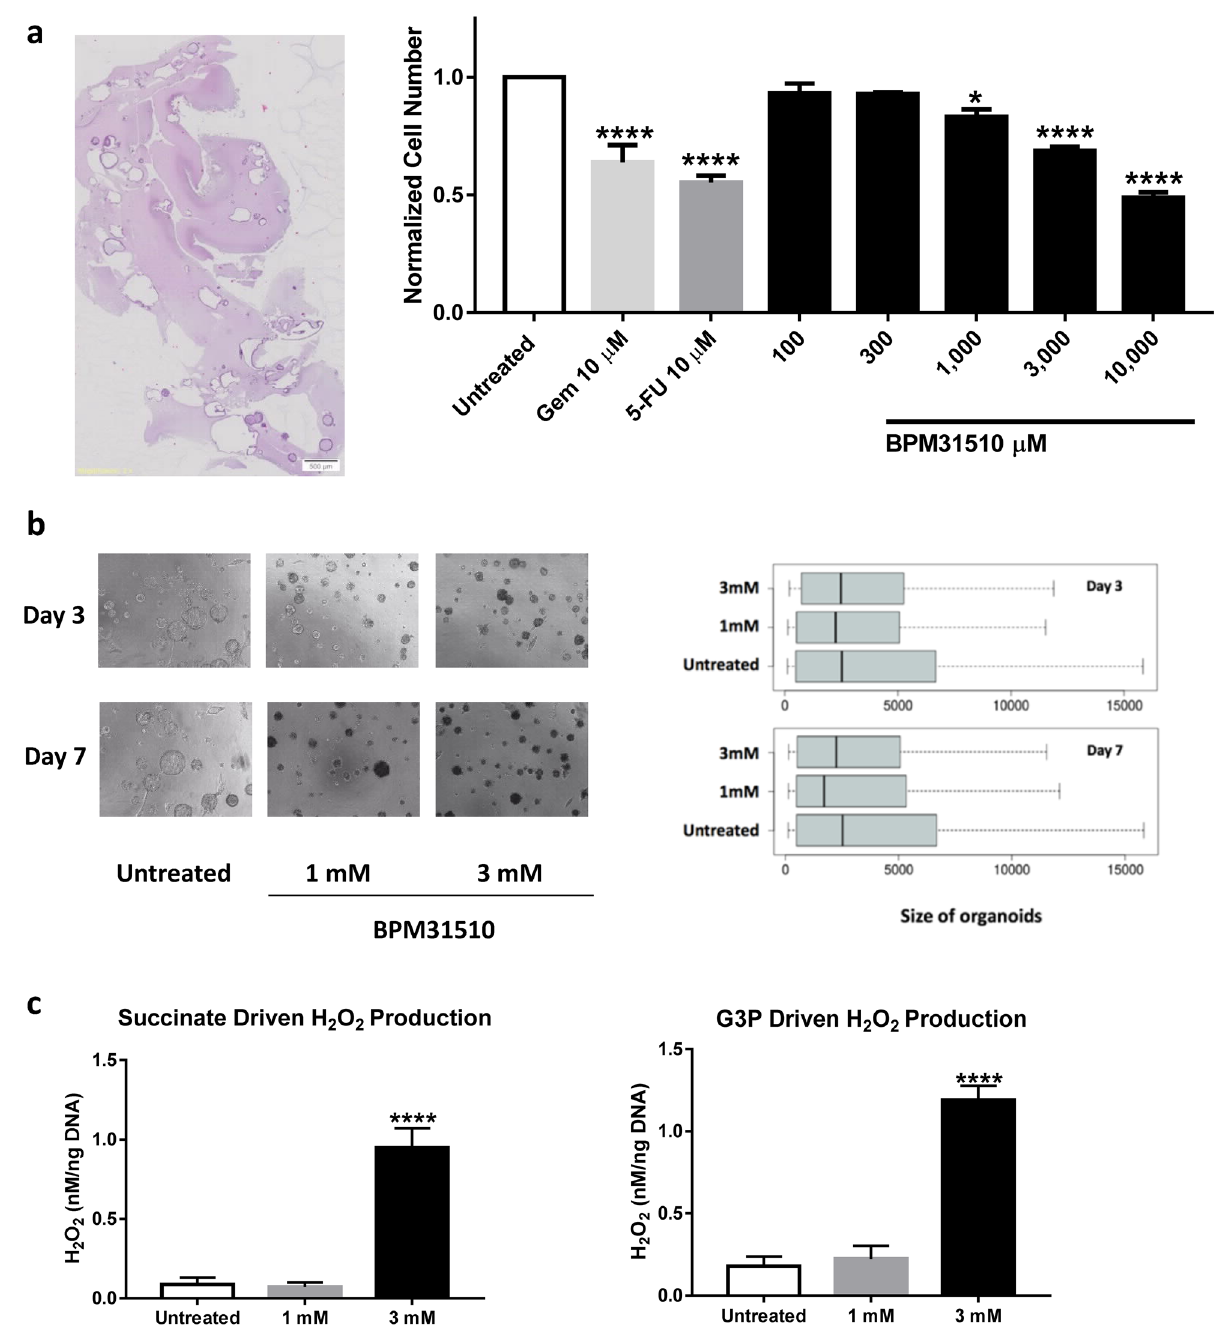
Figure 7. BPM31510 decreases cell viability in patient-derived organoids (PDO) derived from pancreatic tumours, alters G3PDH and Complex II-dependent respiration, and promotes substrate-specific reactive oxygen species (ROS) production. ( a ) Haematoxylin and eosin-stained PDOs (left panel). PDO viability after treatment with BPM31510 (right panel). PDOs were untreated or treated with either DMSO or a toxic mix of cyclohexane (50 µg/mL) and puromycin (2 µg/mL), gemcitabine (1 or 10 µM), 5-FU (1 or 10 µM), or BPM31510 (100– 10,000 µM) for 72 h, and cell viability was assessed using a CytoTOX Glo cytotoxicity assay. The data represent the means ± SEM of three biological replicates. ( b ) BPM31510 decreases PDO size after 72 h of treatment. Representative images of PDO after 3 and 7 days of treatment with BPM31510 (left). The boxplots represent the distribution of PDO size following treatment (right). ( c ) Mitochondrial H 2 O 2 generation during succinate- driven (left) and G3PDH-driven (right) respiration in PDOs after BPM31510 treatment. The data represent the means ± SEM of three independent experiments. All data were analysed by one-way ANOVA followed by Dunnett’s or Tukey’s post hoc test; * p < 0.05, *** p < 0.01, **** p < 0.001 compared to the untreated control